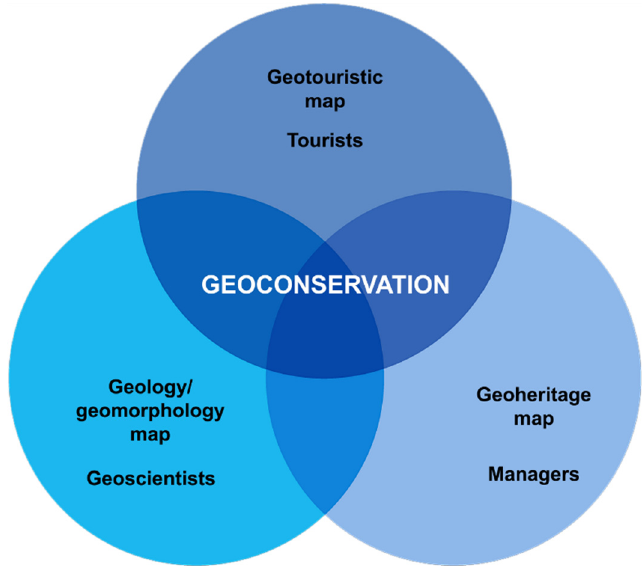
Figure 1. Geoconservation relationships among agents (modified from [10]).